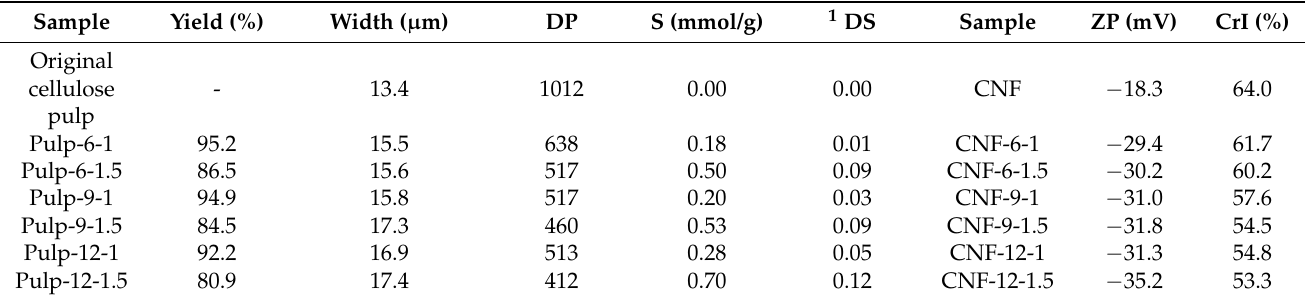
Table 3. Characterization of pulp fibers and